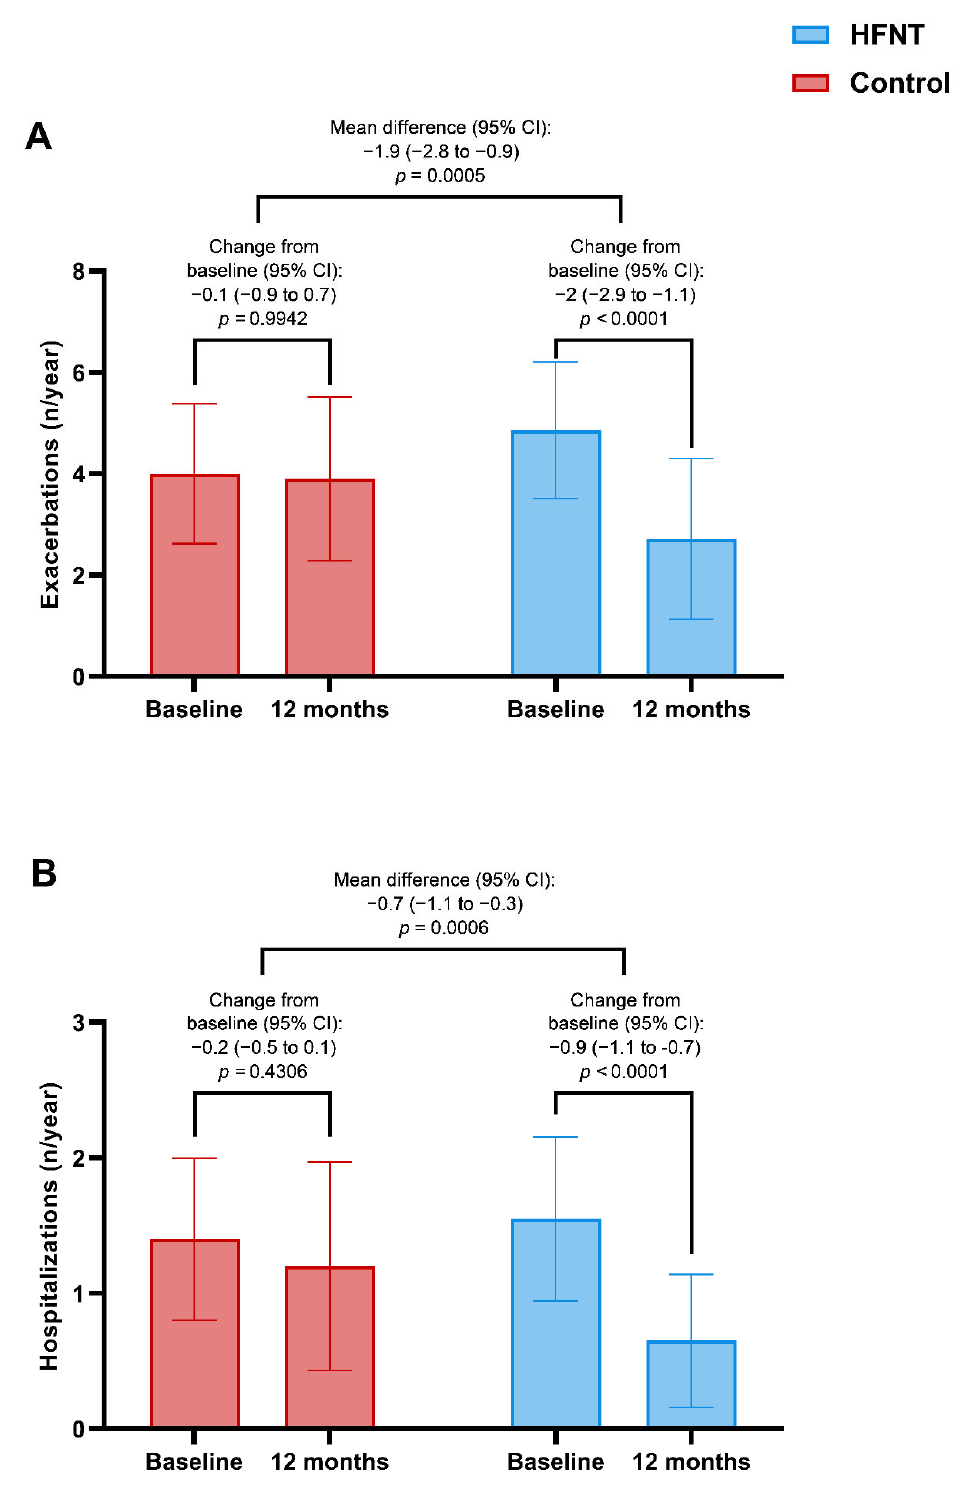
Figure 2. Exacerbations ( A ) and hospitalizations ( B ) in HFNT and control group at baseline and after 12 months. Abbreviations: HFNT, high ‐ flow nasal therapy.